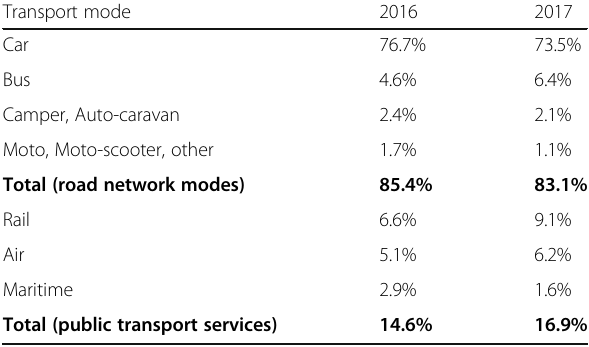
Table 1 distribution by transport mode of tourist trips in Italy Transport